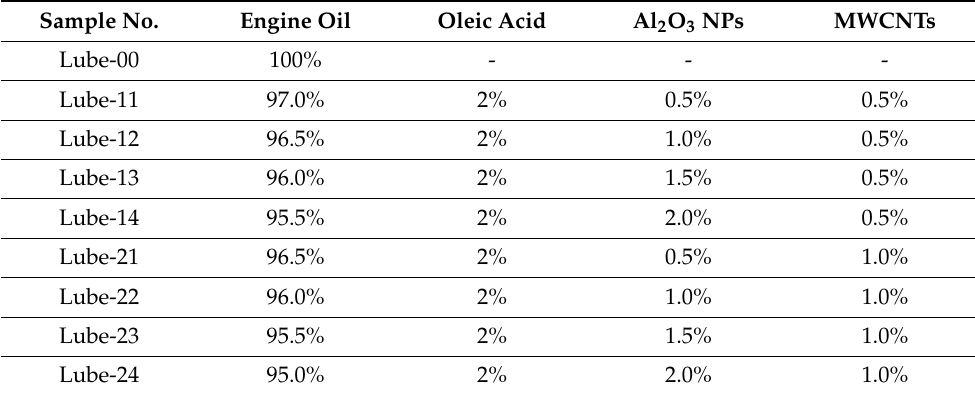
Table 2. Various sample compositions of hybrid nano